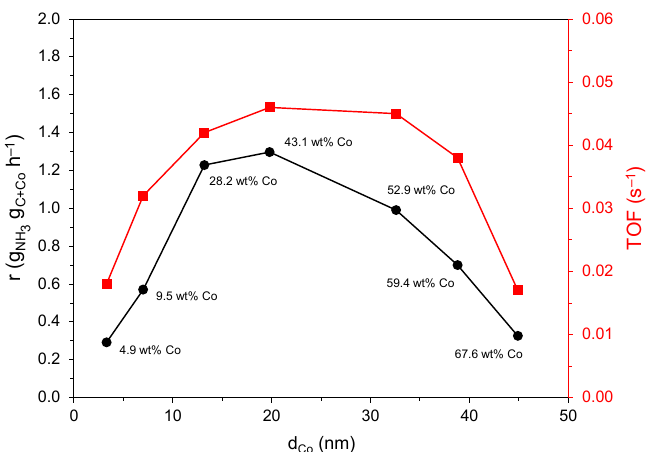
Figure 6. Dependence of activity of the Ba-Co/C catalysts on the cobalt particle size (d Co ). Activity expressed as an average NH 3 synthesis reaction rate (r) and surface reaction rate (TOF); measurement conditions: T = 400 °C, p = 9.0 MPa, H 2 + N 2 + NH 3 flow rate 70 dm 3 h − 1 , H 2 /N 2 = 3, x NH3 = 8.5 mol%; TOF determined based on average reaction rate (r) values and the hydrogen chemisorption data. (Values marked by the points indicate the cobalt content in the catalysts corresponding to the crystallites of a given size. Ba content in all the catalysts was 1 mmol g C − 1 ).